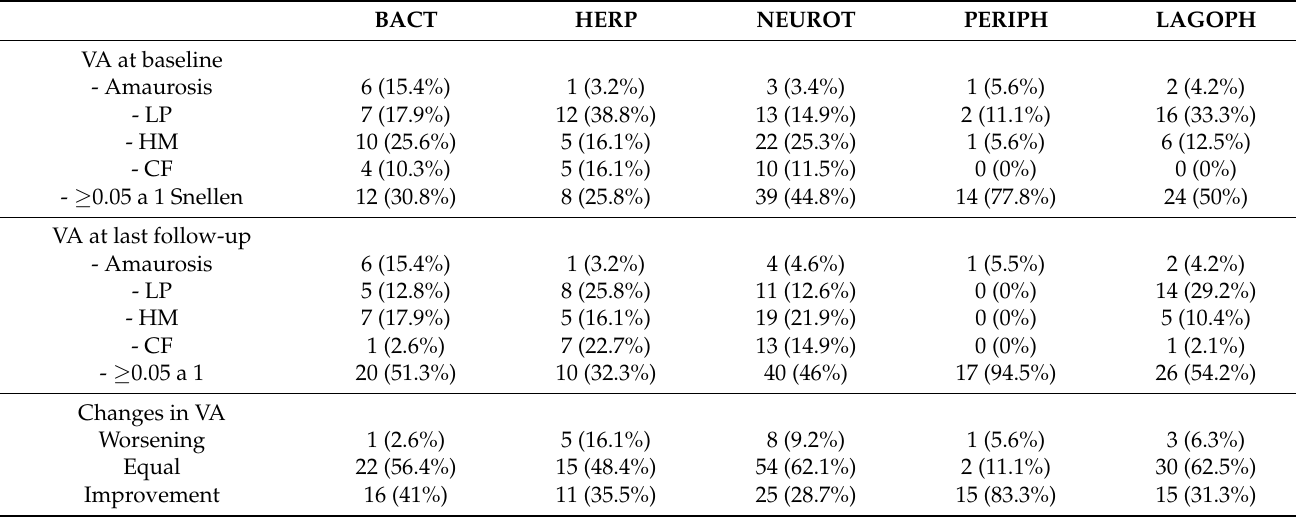
Table 2. Functional results (visual acuity) of amniotic membrane transplantation for each type of ulcer. The minimum last follow-up was 18 months. BACT HERP NEUROT PERIPH